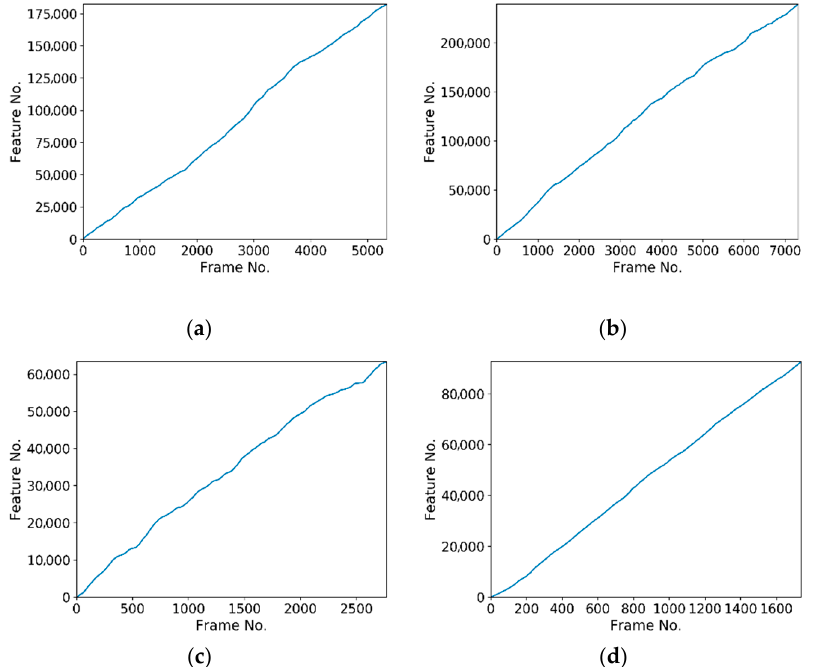
Figure 6. Number of feature points in the o ffl ine experiment: ( a – d ) are the cumulative number of feature